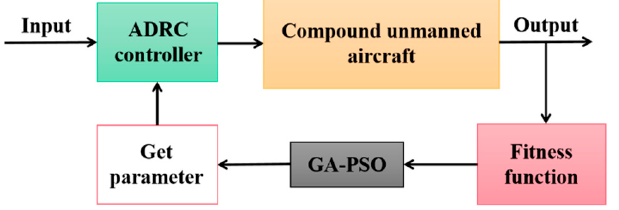
Figure 8. GA-PSO algorithm combined with ADRC control system.